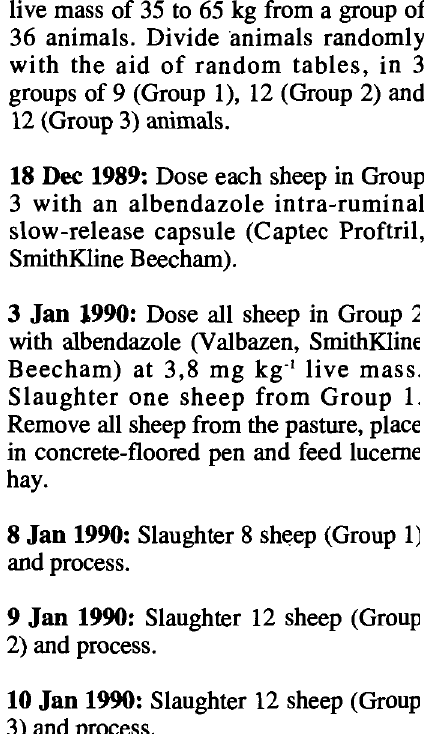
live mass of 35 to 65 kg from a group of 36 animals. Divide animals randomly with the aid of random tables, in 3 groups of 9 (Group 1), 12 (Group 2)